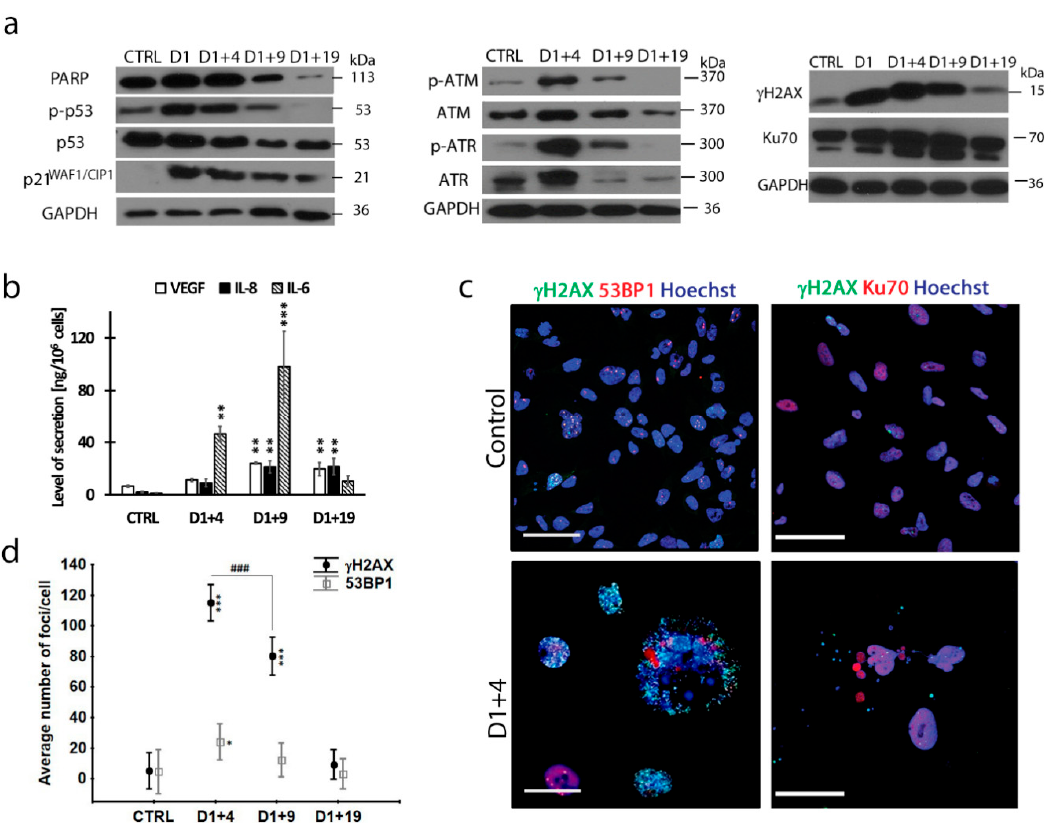
Figure 2. Persistent DNA damage in senescent MDA-MB-231 cells. Cells were treated with 100 nM doxorubicin for 24 h, then cultured in a fresh medium and analyzed on subsequent days. ( a ) Protein level of senescence markers: PARP1 (Poly [ADP-ribose] polymerase 1), p-53, p53 and p21WAF1 / CIP1 and elements of DNA damage response: p-ATM, ATM, p-ATR, ATR, γ H2AX and Ku70; typical western blot image. ( b ) Amount of IL-8, IL-6 and VEGF (Vascular Endothelial Growth Factor) secreted by cells measured by ELISA. Bars: mean value, error bars: SEM, n = 3. ( c ) Representative immunofluorescence images of cells stained for γ H2AX (green), 53BP1 / Ku70 (red) and nuclei stained with Hoechst (blue). Scale bar: 50 µ m. ( d ) Quantification of γ H2AX and 53BP1 foci per cell performed using immunofluorescence microscopy. Each point: mean value ± 0.95 confidence interval, n = 3. Statistical significance (in relation to control): * p < 0.05, ** p < 0.01, *** p < 0.001, between samples: ### p < 0.001